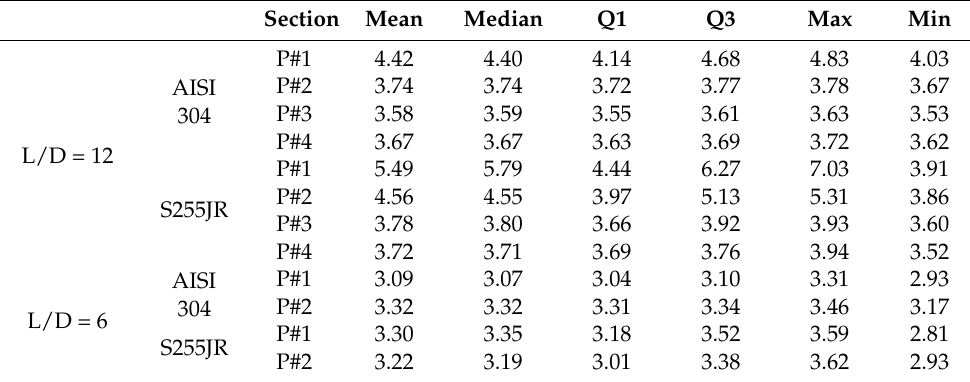
Table 3. Main statistics of the mean square height (Rq) parameter.